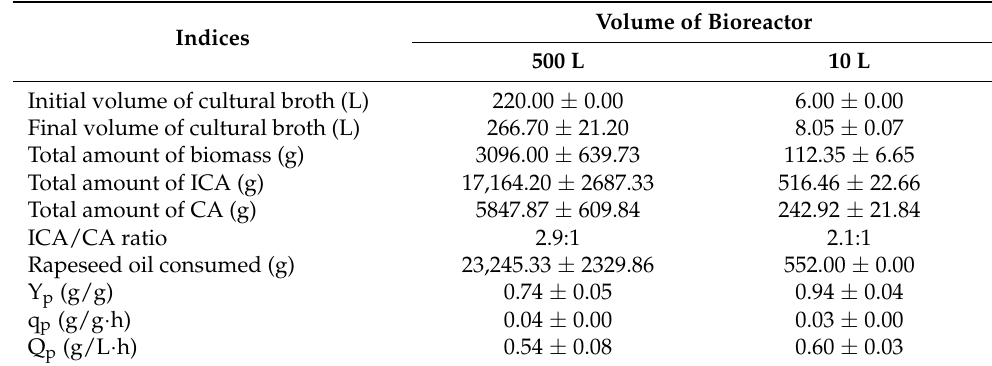
Table 1. Calculated ICA production indices of Y. lipolytica VKM